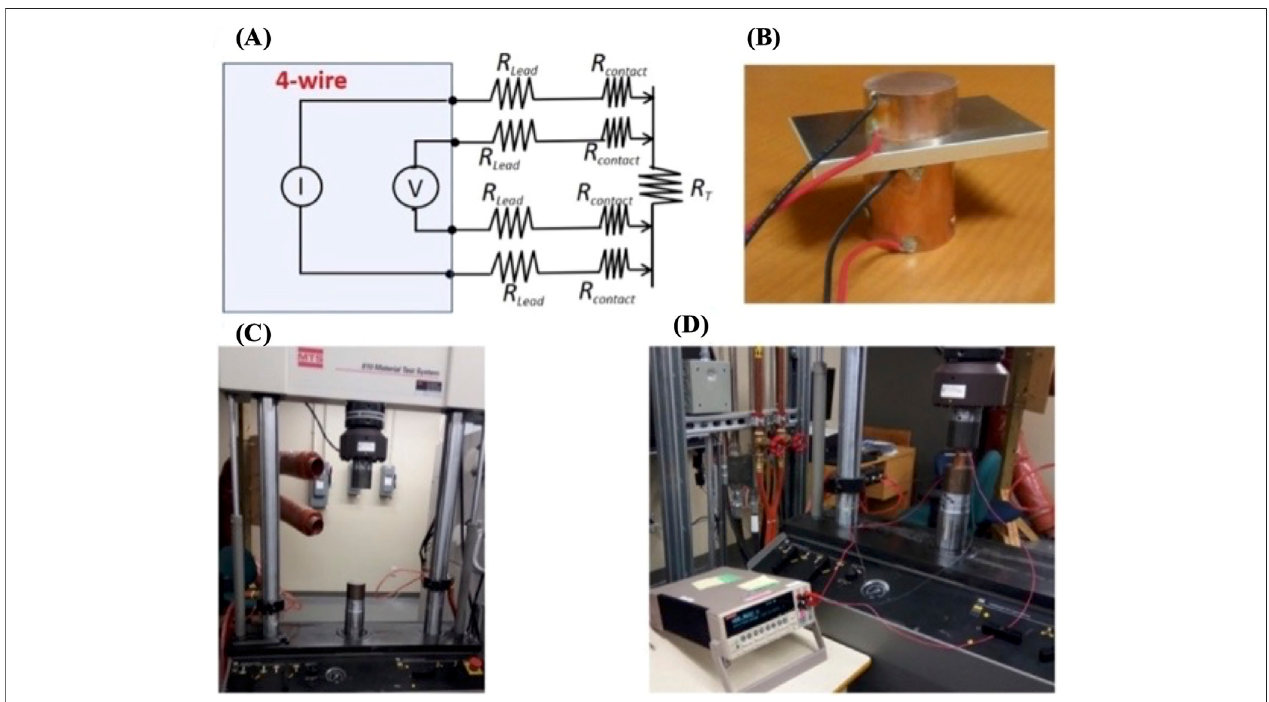
FIGURE 6 | Electrical resistance measurement system. (A) Schematic representation of 4-wire connection. (B) Image of 4-wire connection on copper electrodes. (C) Hydraulic system used for applying 200 pounds. (D) Complete measuring system following MIL-DTL-81706B.